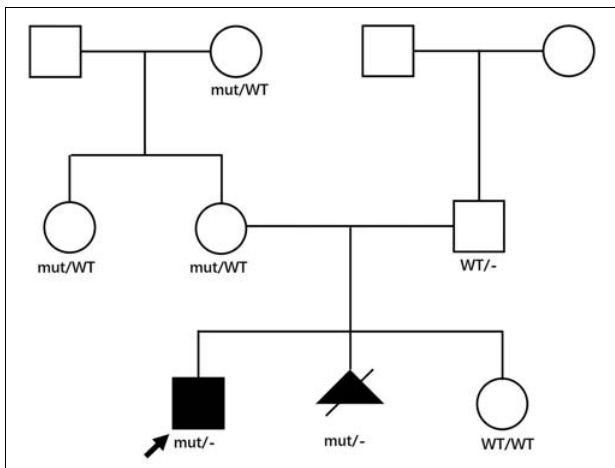
FIGURE 3 | Family pedigree of patient 3. Genotypes in the patient 3’s family were displayed in the pedigree. Affected patients were displayed as black symbols and healthy members were marked in white symbols. mut represented the mutant X allele with c.5739 + 362A > G, WT represented the wild type X allele, – represented Y allele. The proband was indicated with an arrow. The second pregnancy of the proband’s mother was aborted after the same genotype was identified, and the genotype of her third pregnancy was normal.